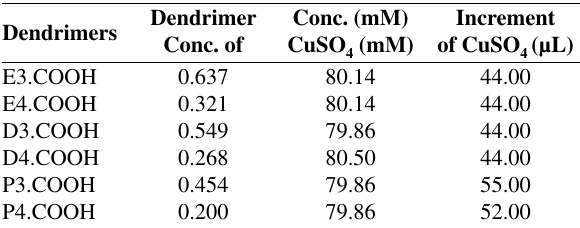
Table 1. Concentrations used to titrate aqueous solutions of PAMAM-COOH dendrimers with Cu 2+ ions. Dendrimers